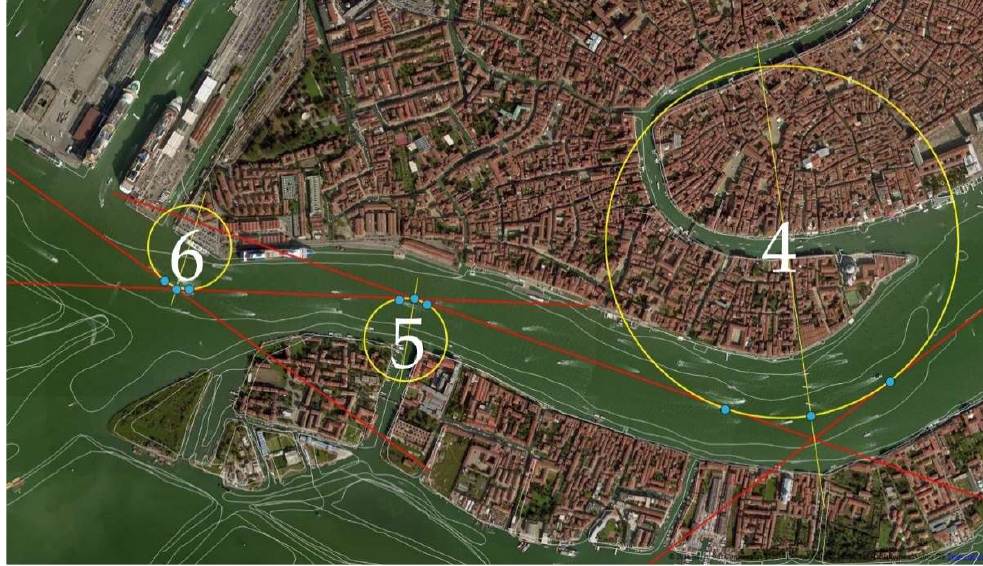
Figure 9. First proposal of Virtual AtoN in the Venetian Canal (light blue dots).